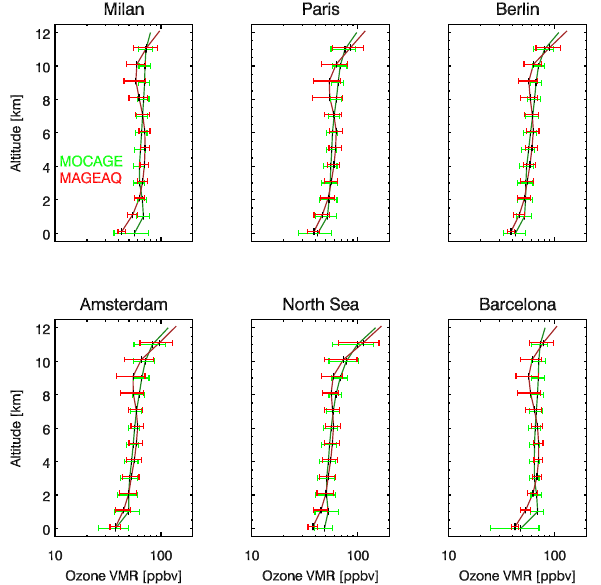
Fig. 9. Mean tropospheric ozone concentration profiles: MOCAGE pseudo-reality (green) and MAGEAQ-TIR pseudo-observation (red), at Milan (Italy), Paris (France), Berlin (Germany), Amsterdam (the Netherlands), one marine location West of Norway coast (55 ◦ N/8 ◦ E), Barcelona (Spain). Error bars indicate the standard deviations.